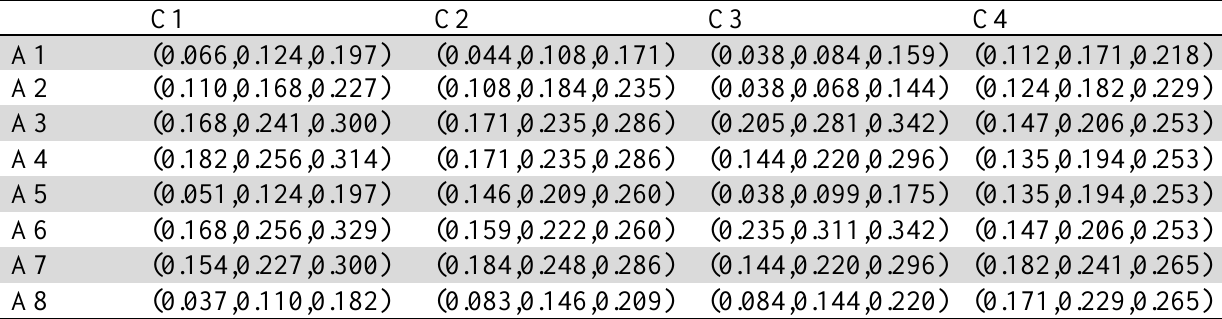
Normalized fuzzy decision matrix for SMS